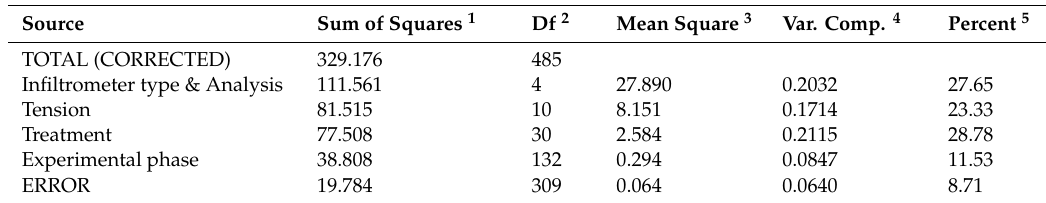
Table 4. Results of Variance component analysis evaluating factors contributing to total variability in log K(h); The columns show: 1 decomposition of the sum of squared deviations around the grand mean, 2 degree of freedom associated with each sum of squares, 3 sums of squares divided by their degrees of freedom, 4 estimated variance components and 5 percentage of the total process variance represented by each component.